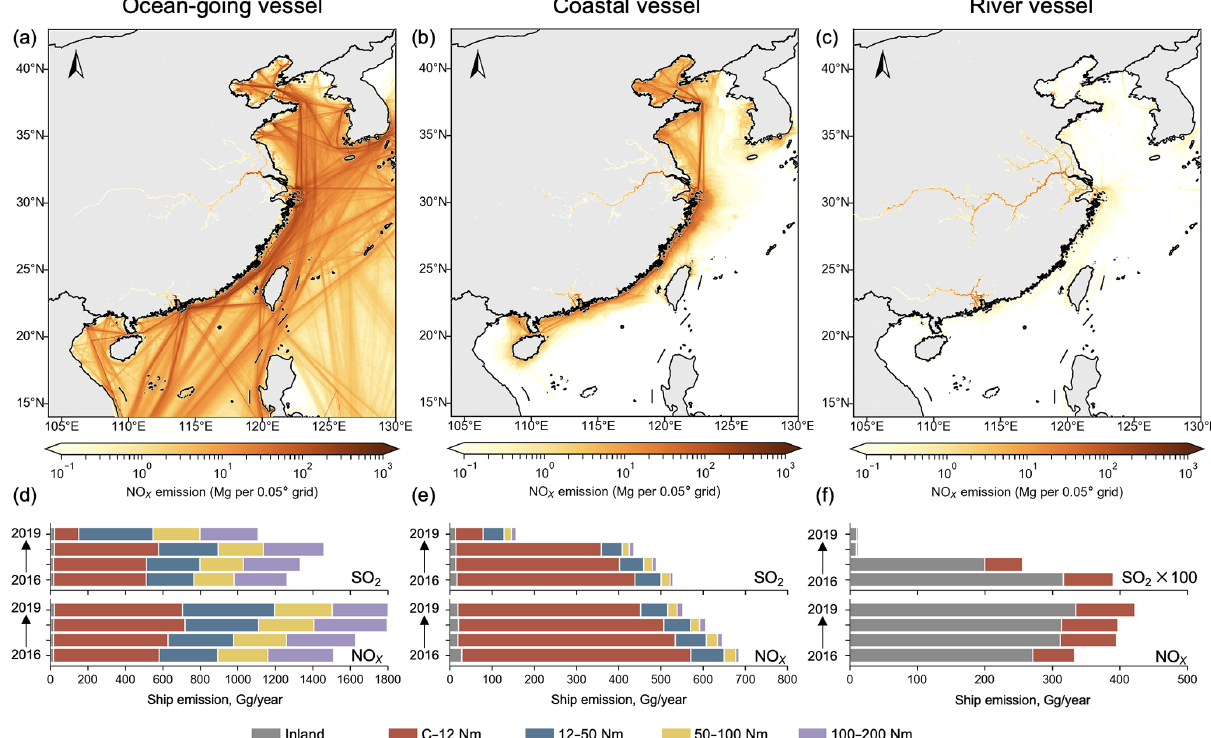
Figure 12. Interannual spatial changes in NO x and SO 2 emissions from ships over China from 2016 to 2019. Annual average spatial distribution comparison of NO x emission for (a) OGVs, (b) CVs and (c) RVs. Interannual variations in NO x and SO 2 emissions in different geographic regions for (d) OGVs, (e) CVs and (f)